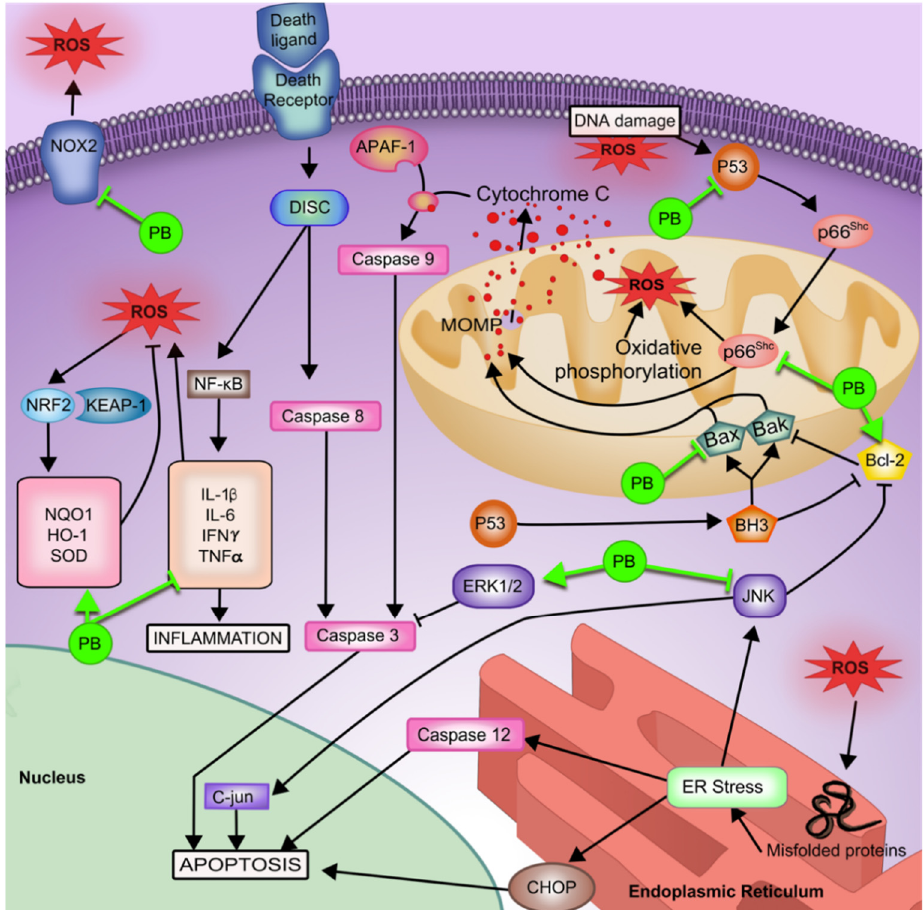
Figure 1. Schematic diagram of various cellular therapeutic effects of probucol in context of oxidative stress induced pathologies underlying ARHL. Abbreviations: PB, probucol; DNA, deoxyribonucleic acid; ROS, reactive oxygen species; NRF2, NF-E2-related factor 2; KEAP-1, Kelch-like ECH-associated protein 1; NQO1, NAD(P)H:quinone oxioreductase-1; HO-1, heme oxygenase-1; SOD, superoxide dismutase; DISC, death inducing signalling complex; IL-6, Interleukin-6; IL-1 β , interleukin-1 beta; IFN γ , interferon-gamma; TNF α , tumour necrosis factor-alpha; NF- κ B, nuclear factor-kappa B; BH3, BH3 only protein; MOMP, mitochondrial outer membrane pore; JNK, c-Jun N-terminal; ERK1/2, extracellular signal-related kinases 1 and 2; CHOP, C/EBP homologous protein; ER, endoplasmic reticulum.